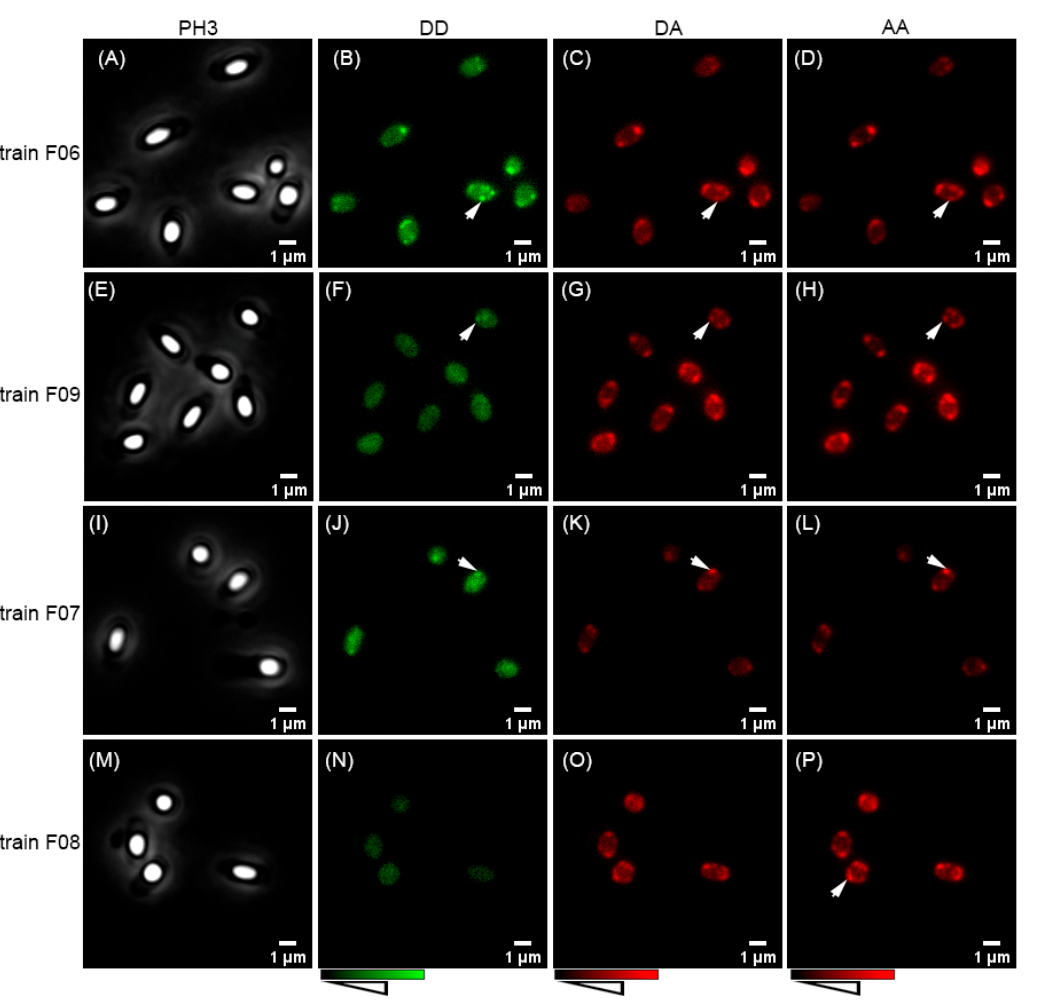
Figure 4. Images of dormant spores of B. cereus strains F06–F09. Panels ( A – D )—GerRA-C-B–SGFP2 and GerD–mScarlet-I independently expressed in spores of strain F06. Panels ( E – H )—GerRB-SGFP2 and GerD-mScarlet-I independently expressed in spores of strain F09. Panels ( I – L )—GerRA–SGFP2 and GerD–mScarlet-I independently expressed in spores of strain F07. Panels ( M – P )—GerRC–SGFP2 and GerD–mScarlet-I independently expressed in spores of strain F08. Column PH3 has phase-contrast images. Column DD has donor images at donor excitation. Column DA has acceptor channel images at donor excitation. Column AA has acceptor images at acceptor excitation. Arrows indicate putative